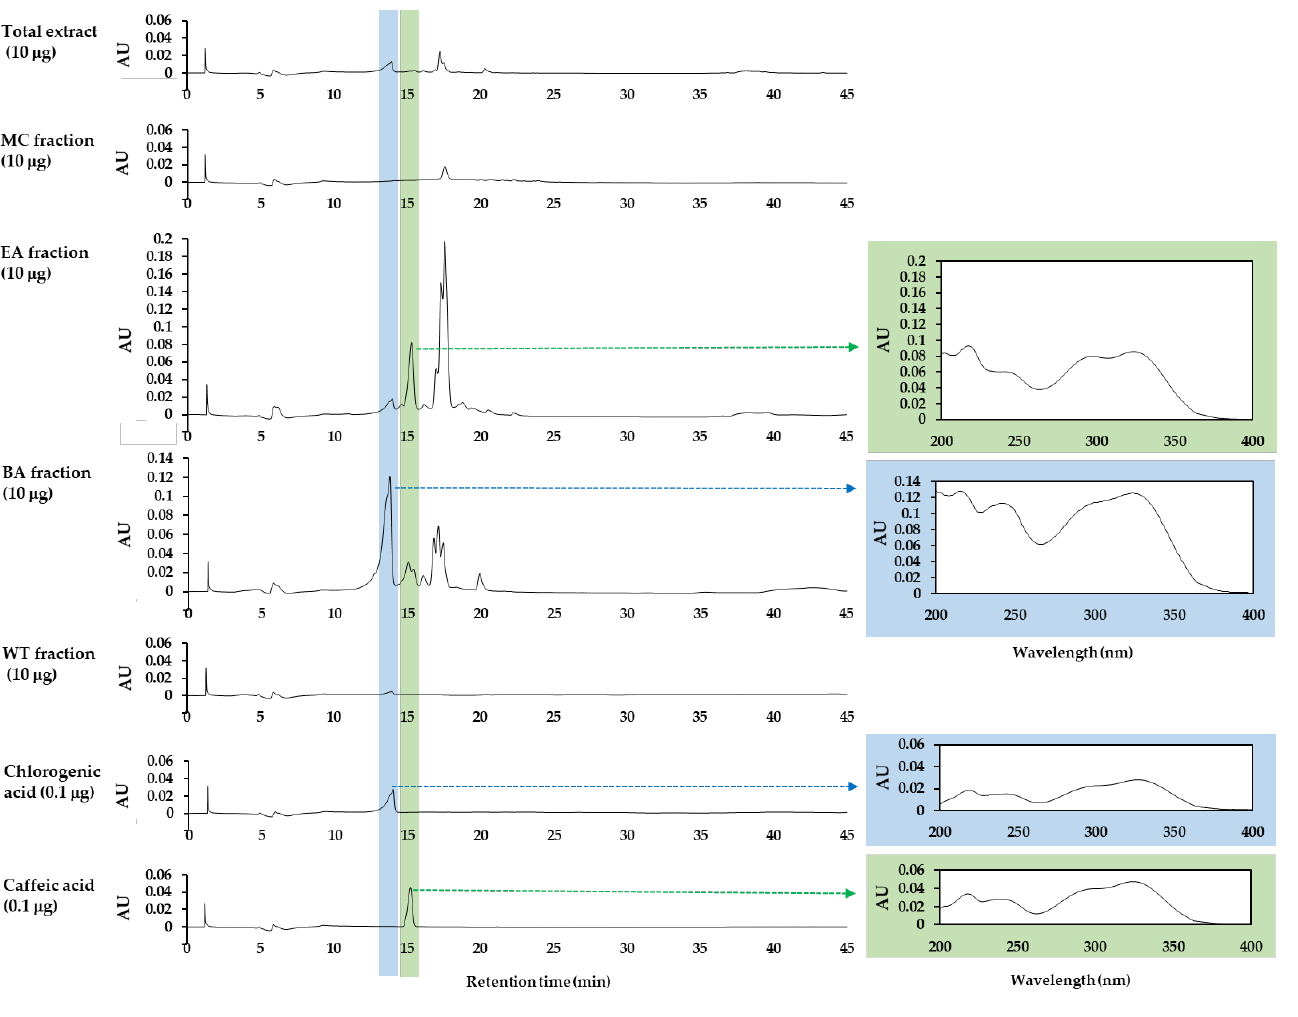
Figure 1. High-performance liquid chromatography with photodiode array detection (HPLC-DAD) analysis of the total extract Oenanthe javanica (Blume) DC, abbreviated OJ, and its MC, EA, BA, and WT fractions. Authentic chlorogenic acid and caffeic acid were used as the standards for comparing the retention times and absorption spectra. Chromatograms at 330 nm and UV absorption spectra of the indicated peaks are shown.